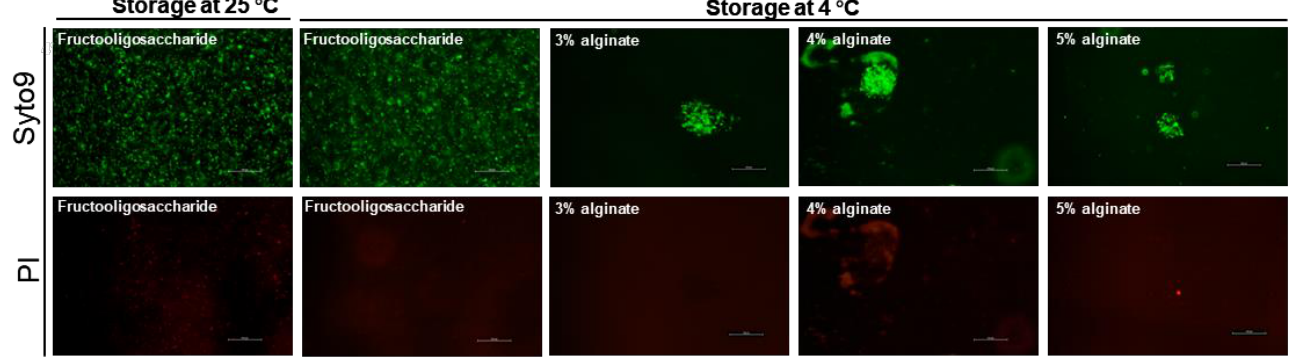
Figure 5. Viability of L. gasseri contained in the gel. The concentration of the encapsulant sodium alginate was 3%, 4%, and 5%. Living and dead bacteria were stained with Syto9 (green), and dead bacteria were stained with PI (red). The scale bar corresponds to 100 µm.